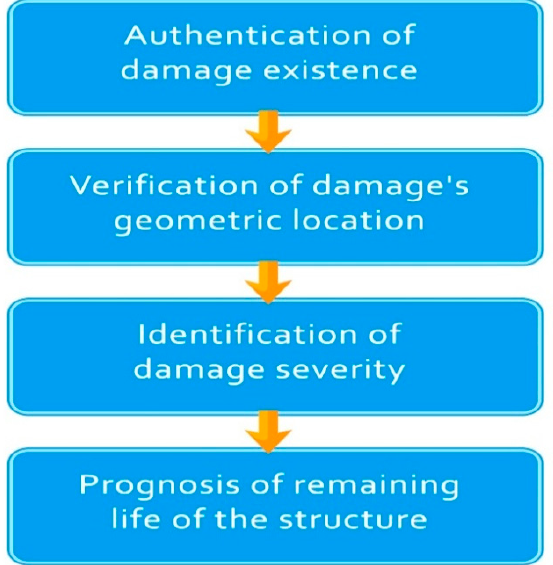
Figure 4. Outline of SHM applications in buildings.